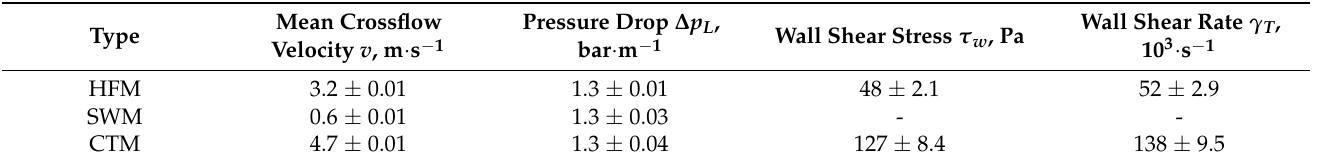
Table 4. Mean crossflow velocity, v , the resulting pressure drop, ∆ p L , the wall shear stress, τ w , and the wall shear rate, γ T , for spiral wound membrane (SWM), ceramic tubular membrane (CTM), and hollow fiber membrane (HFM) at a pressure drop of ∆ p L = 1.3 bar · m − 1 .